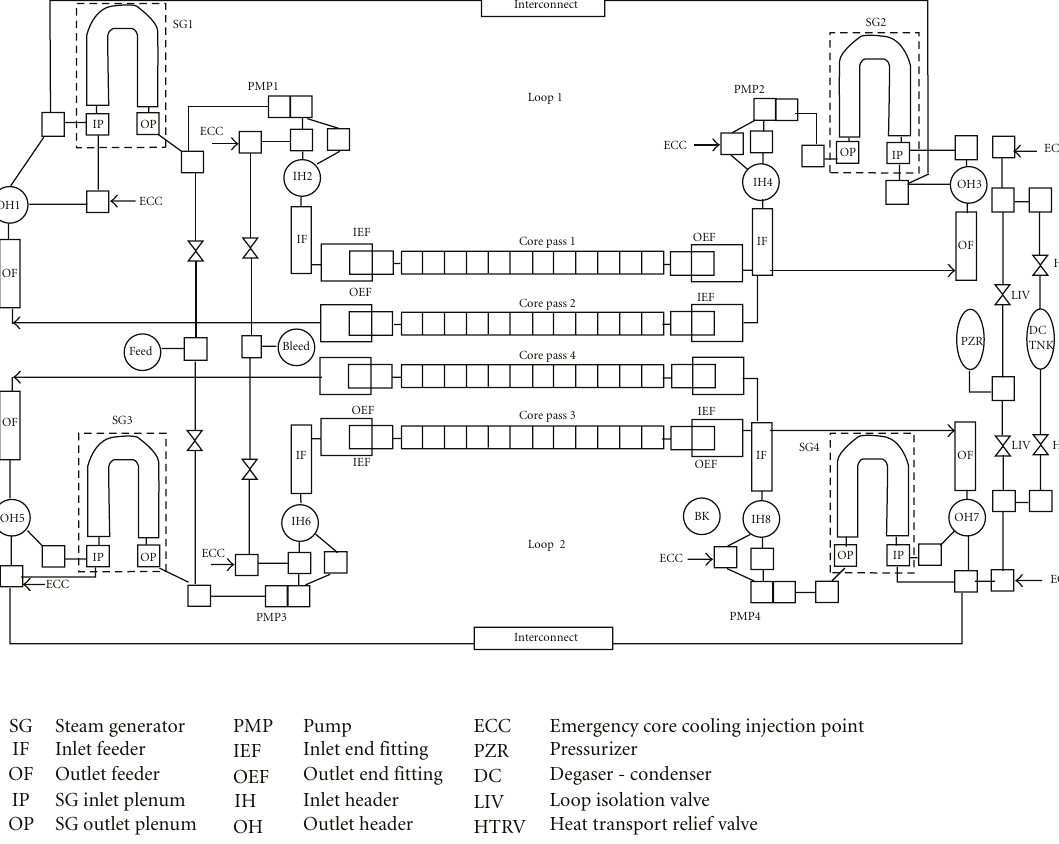
the right of the figure represent the pool on the outside of the calandria vessel. The RELAP5 and SCDAP volumes above and within the COUPLE mesh provide initial and boundary conditions for the debris bed and calandria vessel wall. (The paper also included a more detailed RELAP5 nodalization of the outer pool at the elevations associated with the debris bed. The more detailed nodalization resulted in significantly lower pool containment pressures upon vessel failure due to the more accurate representation of the external cooling of the calandria